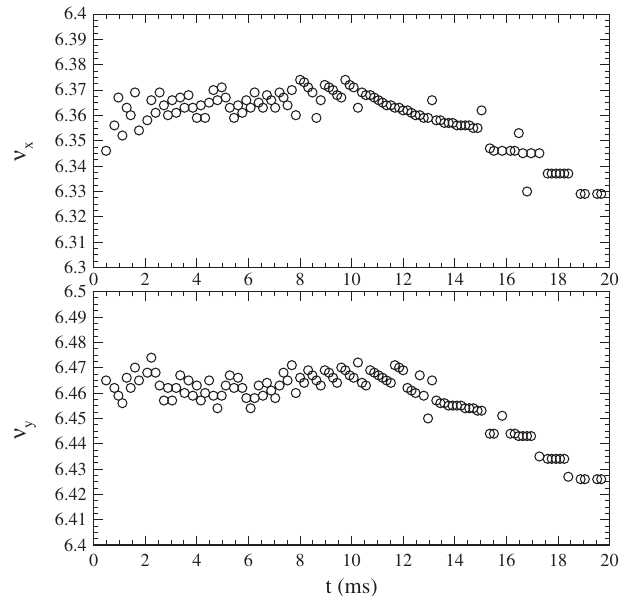
FIG. 27. Horizontal (upper) and vertical (lower) tune varia- tions measured over the acceleration process, where the mag- netic field tracking for the quadrupole magnets was manipulated.